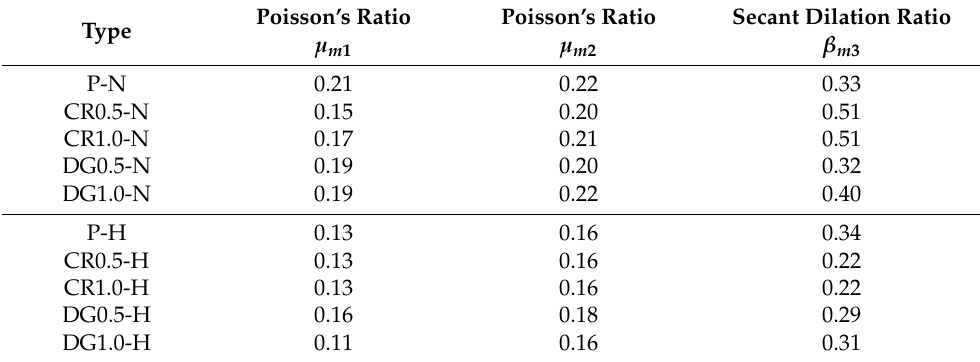
Table 3. Poisson’s ratios and secant dilation ratio in the monotonic compressive